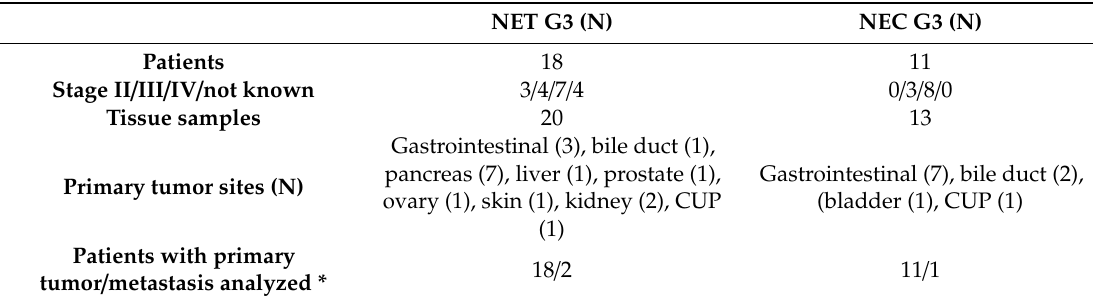
Table 4. Patient characteristics for samples used for digital spatial profiling.